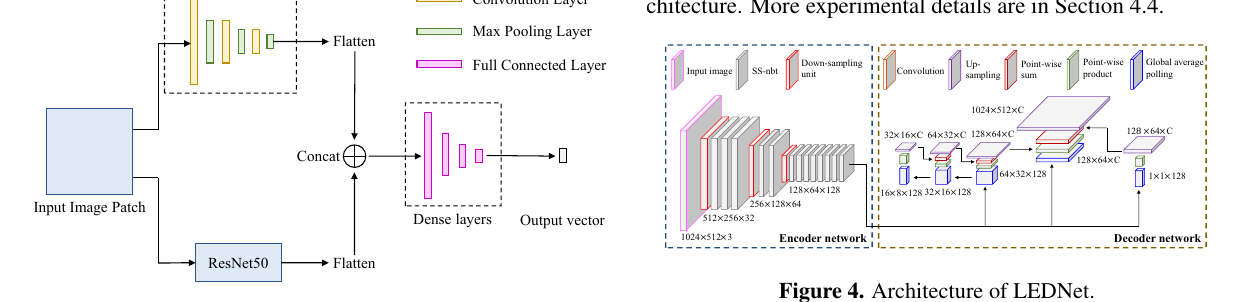
Figure 3. Architecture of network model in the xBD baseline for damage level classification.